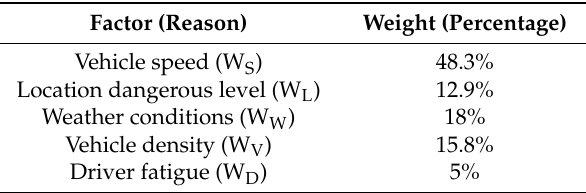
Table 3. Observation factors